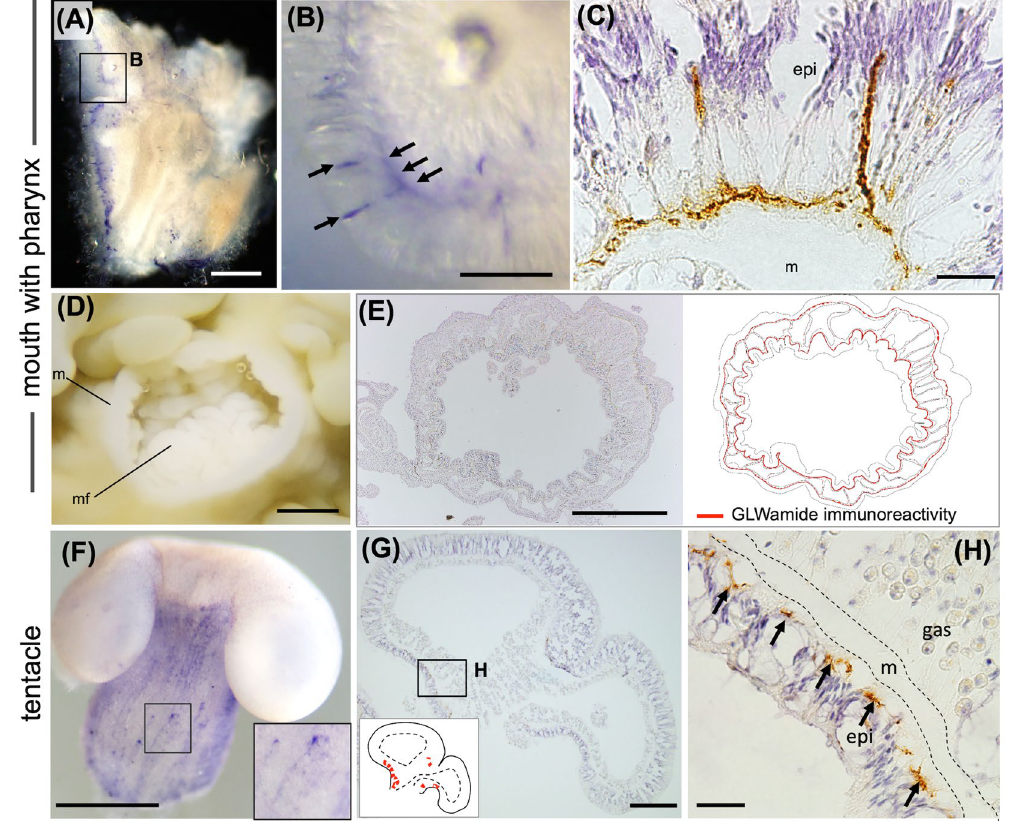
Figure 4. Detection of GLWamide neurons in the mouth (with pharynx) and tentacle of E. ancora . ( A ) Whole-mount immunodetection of GLWamide neurons in an isolated piece of mouth including the pharynx. ( B ) Higher-magnification view of the inset in ( A ). Arrows indicate GLWamide neurons exhibiting immunoreactivity (purple color). ( C ) Immunohistochemical detection of GLWamide neurons (brown color) in the mouth. ( D ) Representative picture of the mouth located at the middle of the polyp (above view). Note that the polyp became cream-colored due to fixation and preservation in ethanol. m, mouth; mf, mesenterial filament. ( E ) Immunohistochemical detection of GLWamide neurons in the identical mouth sample shown in ( D ). The schematic illustration on the right shows the distribution of GLWamide neurons (red line). ( F ) Whole- mount immunodetection of GLWamide neurons in an isolated tentacle. The inset shows a higher magnification of the area indicated by the arrows. Cells exhibiting immunoreactivity (purple color) were observed. ( G ) Immunohistochemical detection of GLWamide neurons (brown color) in the tentacle. The inset on the left shows a schematic illustration depicting the distribution of GLWamide neurons (red spots). ( H ) Higher- magnification view of the inset in ( G ). Arrows indicate the GLWamide neurons exhibiting immunoreactivity (brown color). m, mesoglea; epi, epidermis; and gas, gastrodermis. Scale bars = 500 μ m ( A ); 100 μ m ( B , C ); 1 mm ( D , E , F ); 200 μ m ( G ); 20 μ m ( H ).